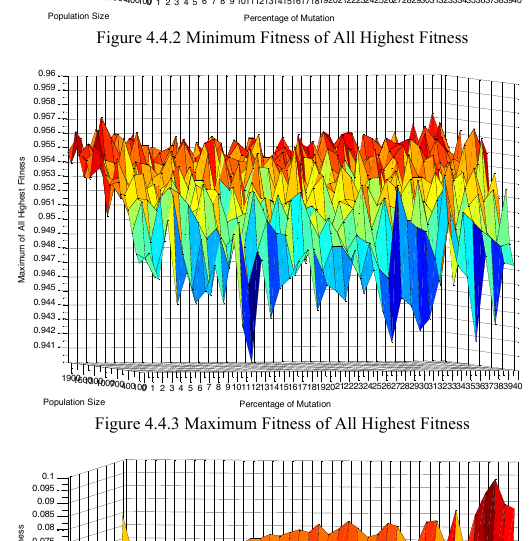
Figure 4.4.2 Minimum Fitness of All Highest Fitness